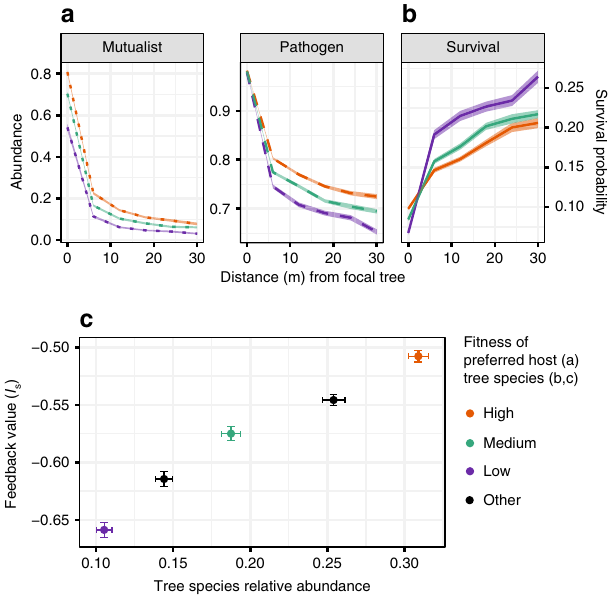
Fig. 2 Spatial results from fi ve-species simulation after 3 K time steps. Results are shown for three (of fi ve) species representing the most fi t, least fi